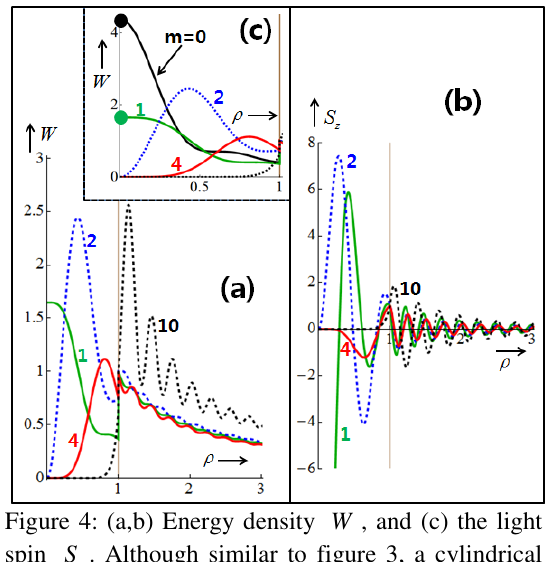
Figure 4: (a,b) Energy density W , and (c) the light S . Although similar to figure 3, a spin z